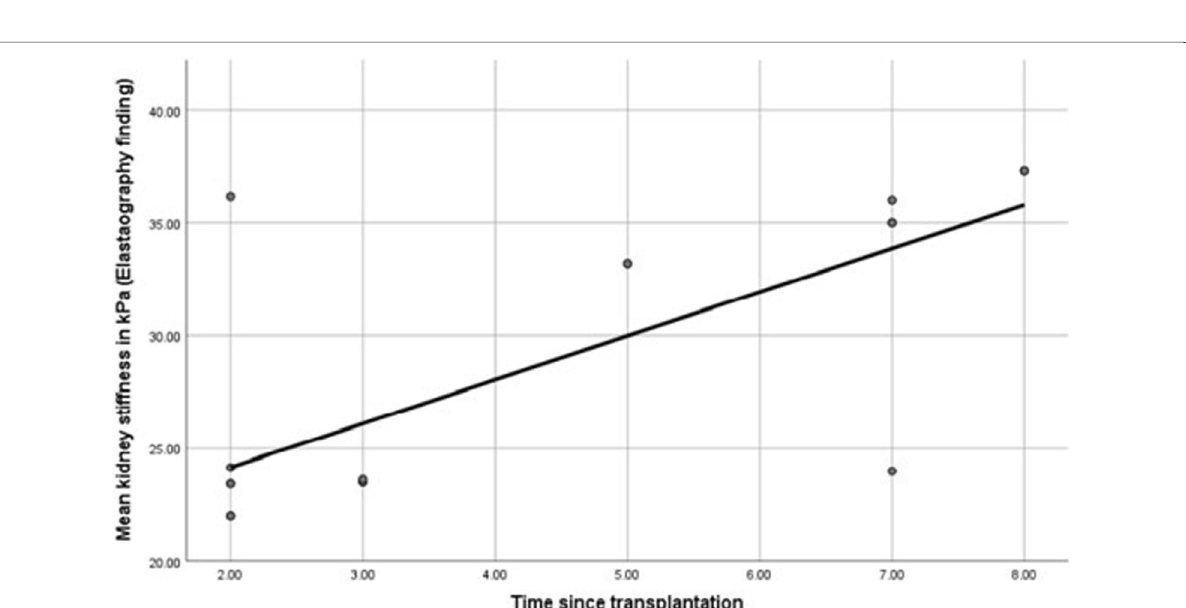
Fig. 4 Scatter plot showing the correlation between mean renal stiffness in and time since